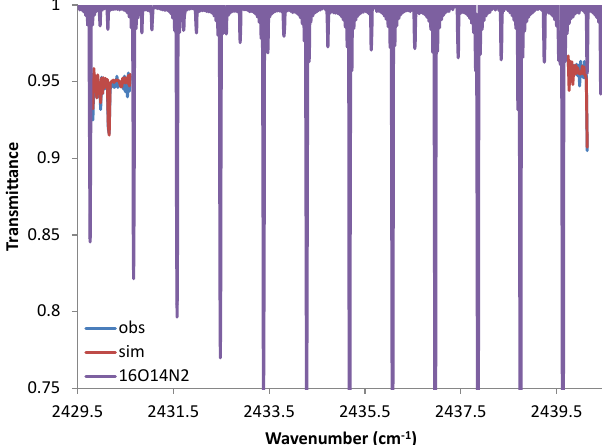
Figure 3a. Observed (“obs”) and simulated (“sim”) transmittance at TH = 12.46km for sunrise 39035 (53 ◦ S, 18 ◦ W) on 12 Novem- ber 2010 for the three microwindows targeting the N 2 CIA at that tangent height. Spectral lines for other relevant species in the region are also shown.